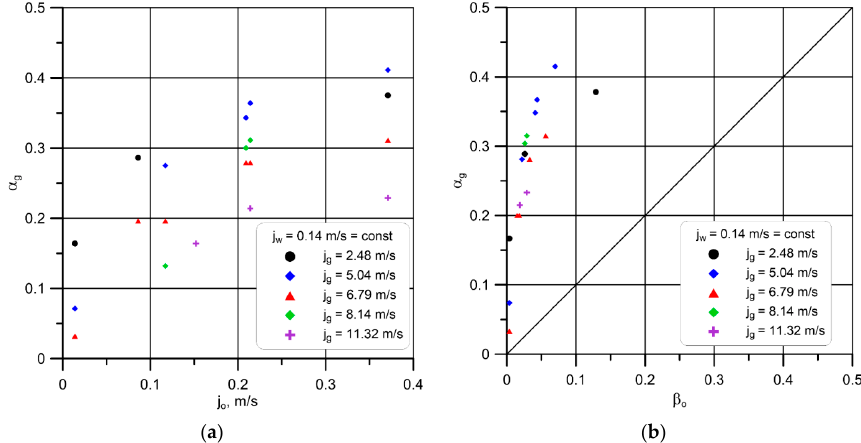
Figure 5. Example applied to illustrate the dependence of oil volume ratio, α o , for oil viscosity of η o = 0.3 Pas on ( a ) the value of the superficial oil velocity, j o , and ( b ) the value of water volume fraction at the channel inlet, β o . Energies 2021 , 14 , x FOR PEER REVIEW